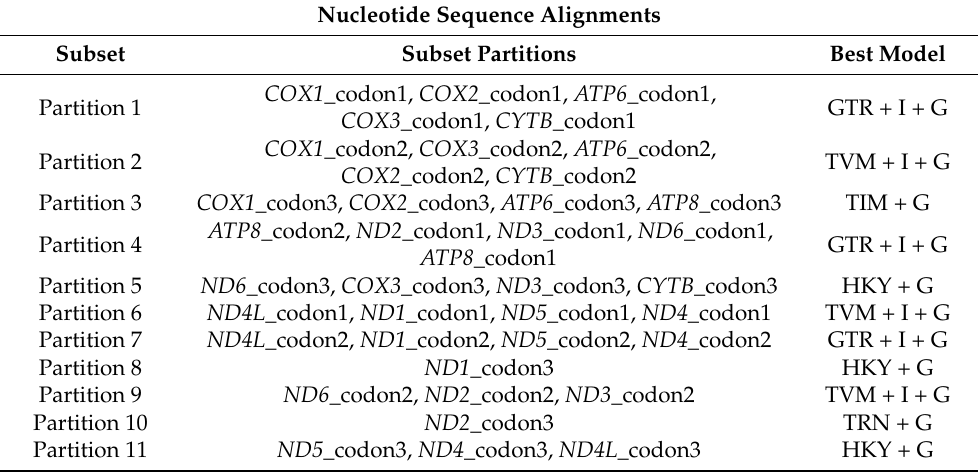
Table 2. The partition schemes and best-fitting models